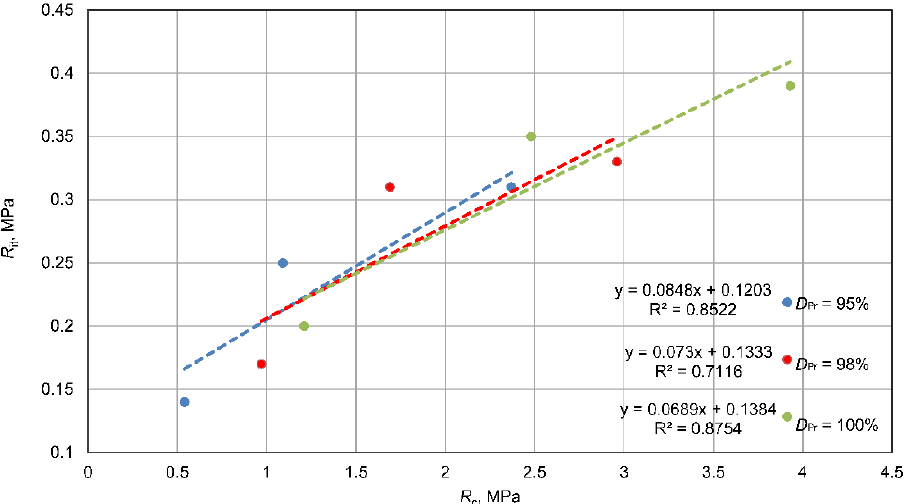
Figure 14. Relationships between unconfined compressive strength, R c , and indirect tensile strength, R it .